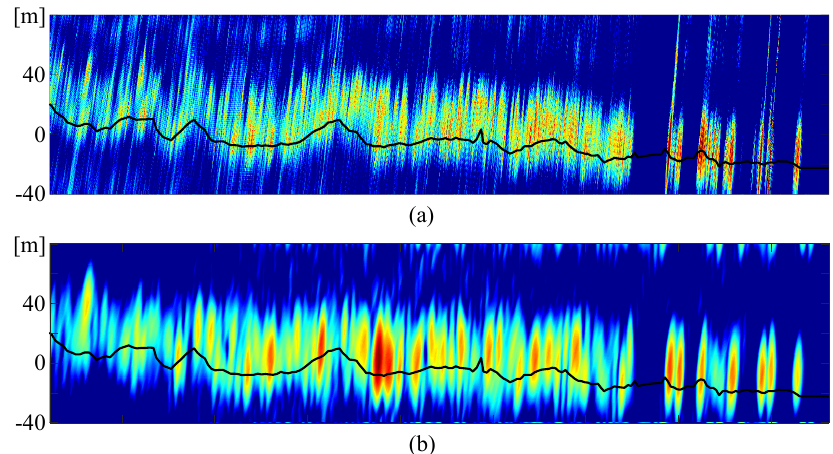
Figure 8. Tomographic profiles returned by the back-projection algorithms when applied to ( a ) real airborne data and ( b ) simulated spaceborne stack. The two axes are analogous to the ones shown in Figure 5; the black line shows the ground topography below the forest layer estimated through SAR tomography